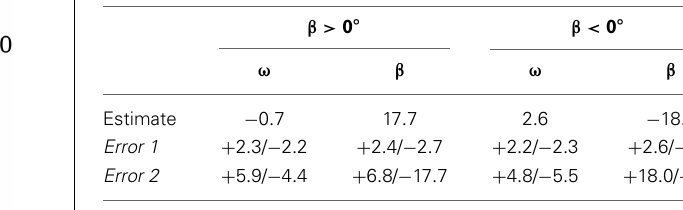
Table 4 | Geometry parameters resulting from Fourier vector